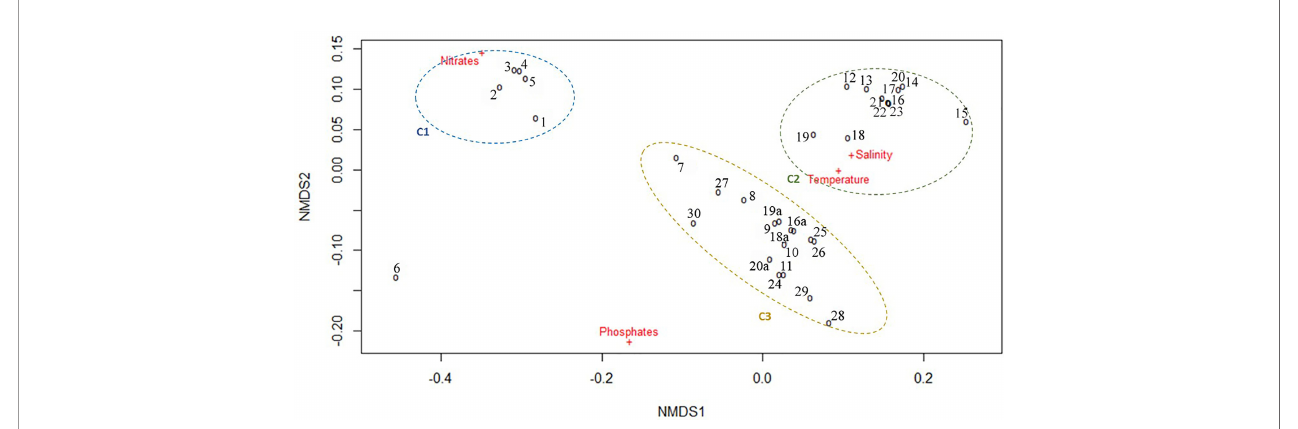
FIGURE 5 | NMDS plot of multiyear environmental data by sampling stations.